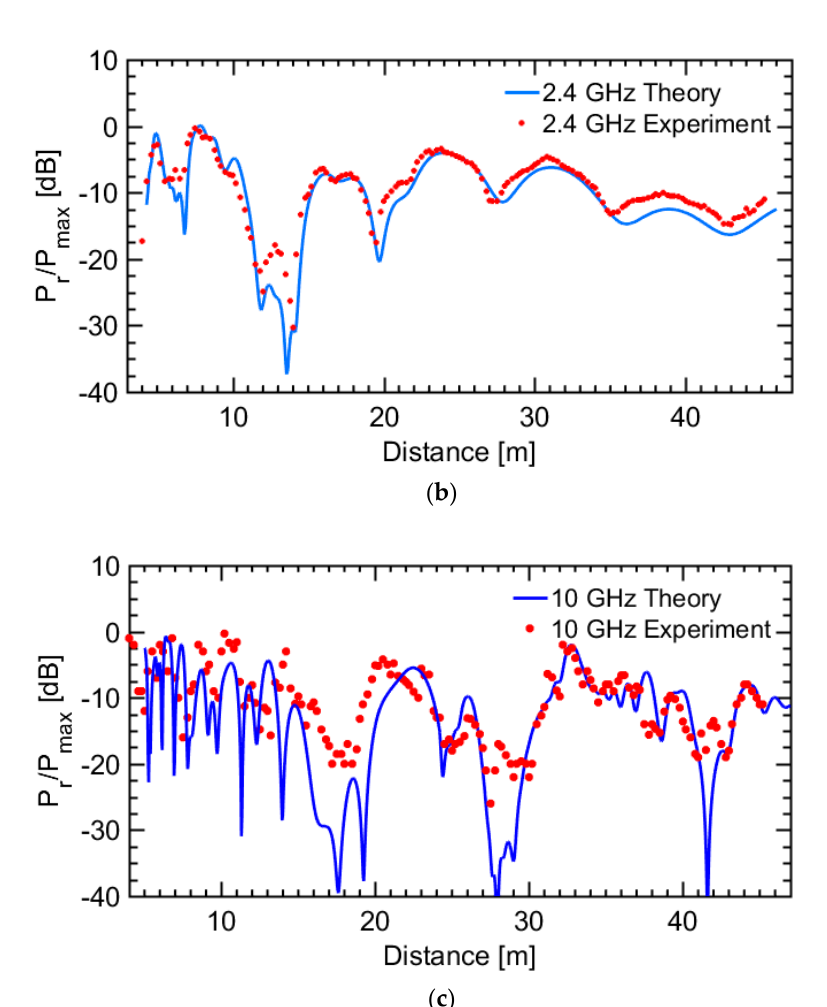
Figure 5. Normalized results of the field experiments and simulation as a function of distance in a rectangular tunnel for different frequencies of ( a ) UHF 1 GHz, ( b ) UHF 2.4 GHz, and ( c ) SHF 10 GHz.